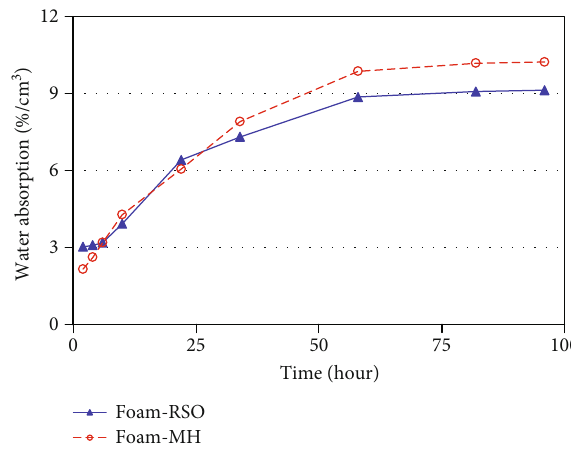
Figure 13: The water absorption of Foam-RSO and Foam-MH.